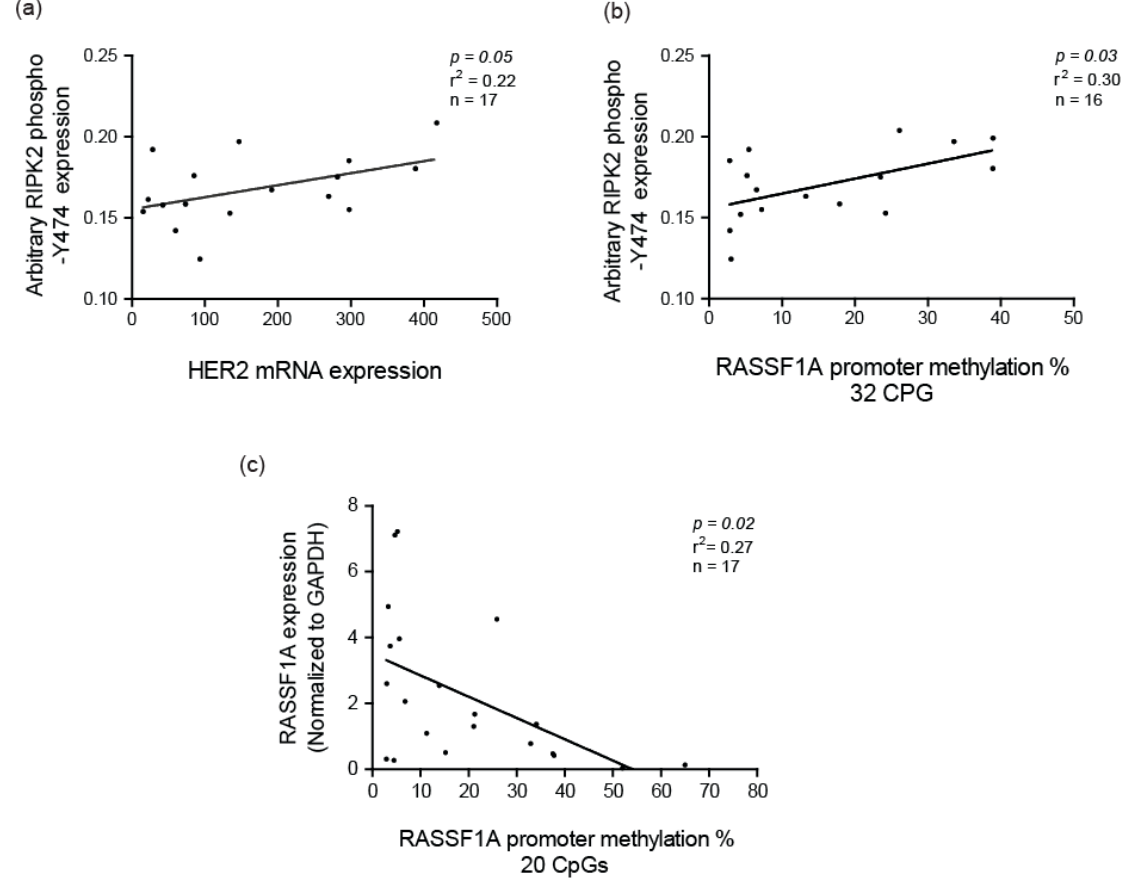
Figure 7. Correlation of active RIPK2 expression with HER2 mRNA expression: ( a ) and Ras association domain family protein 1A ( RASSF1A) CpG methylation percentage; ( b ) correlation of RASSF1A mRNA expression and RASSF1A CpG methylation percentage; and ( c ) in IBC. CpG methylation analysis was carried out as described elsewhere [67] with focus on 32 CpG residues before the transcriptional start site (32 CpG x -axis label I ( b ) and CpG 13–32 (20 CpG) from the transcription start site.